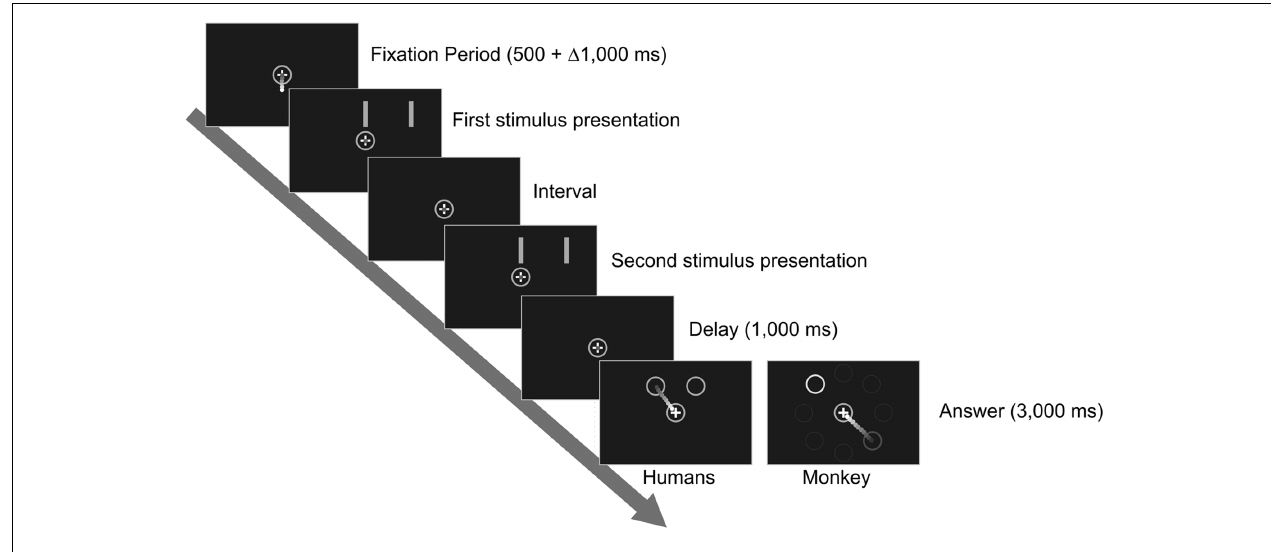
categorized it as “long.”The monkey moved the cursor toward the circle with an orange outline if its decision was “short” and toward the circle with a blue outline if its decision was “long.” Depicted are the eight possible positions that the response circles could adopt in the monkey response configuration. In a particular trial only the two response circles were